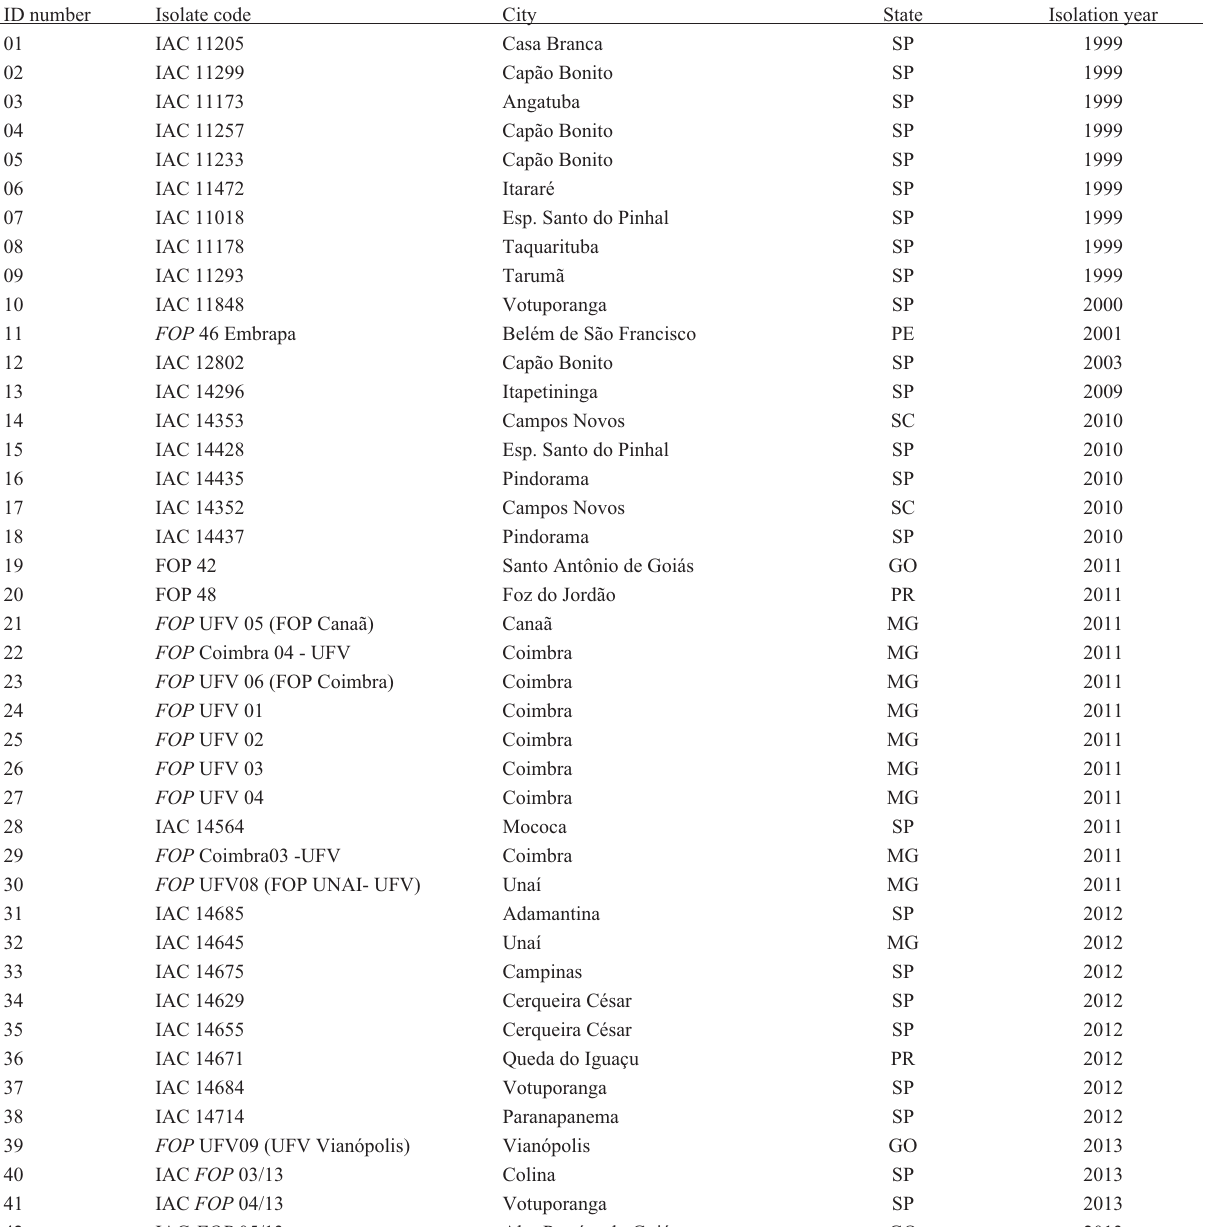
Table 1 - Fusarium oxysporum f. sp. phaseoli isolates with their respective origins and